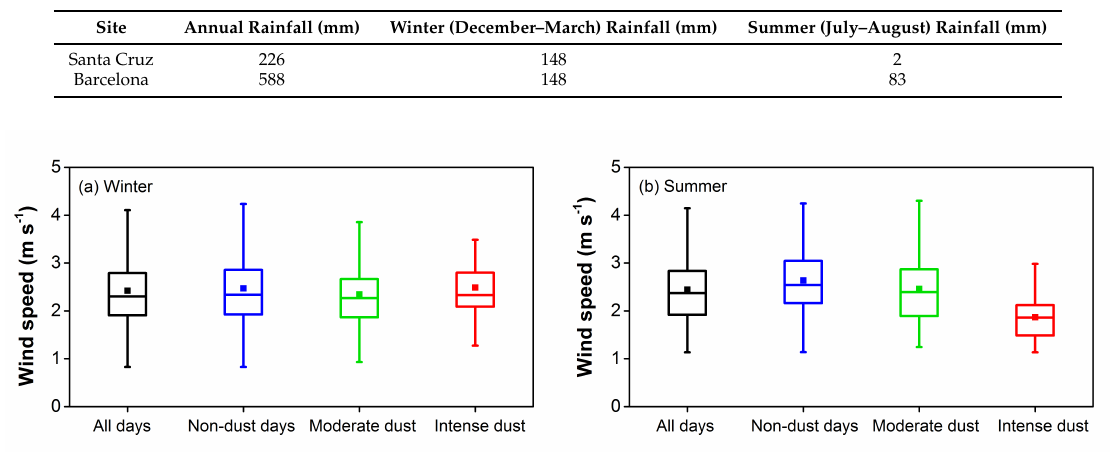
Figure A1. ( a ) Location of the Canary Islands; ( b ) topographic map of Tenerife (Carta Digital v2.0); and ( c ) plan view of Santa Cruz de Tenerife indicating the location of the air-quality measurement sites (1) Tena Artigas, (2) Vuelta Los Pájaros, (3) Piscina Municipal, and (4) the meteorological station (AEMET: C449C). Table A1. Climatological rainfall values (1981–2010) for Santa Cruz de Tenerife (C449C) and Barcelona Airport (0076) meteorological stations (AEMET).